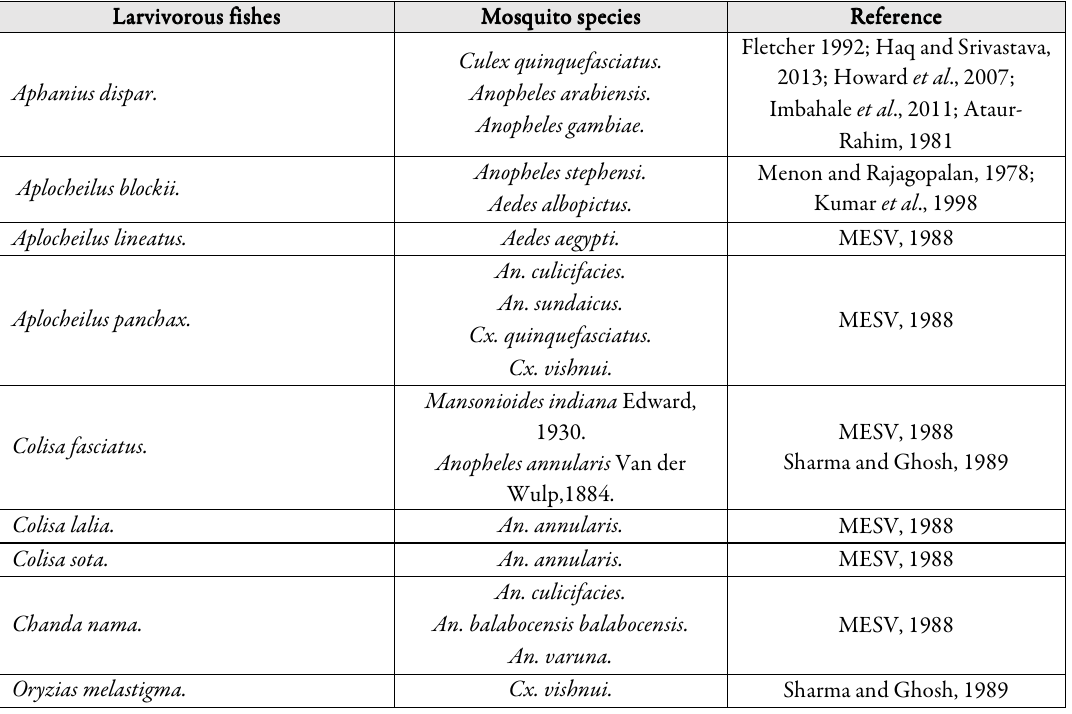
Table 5. Potential indigenous larvivorous fishes as biocontrol agent Larvivorous fishes Mosquito species